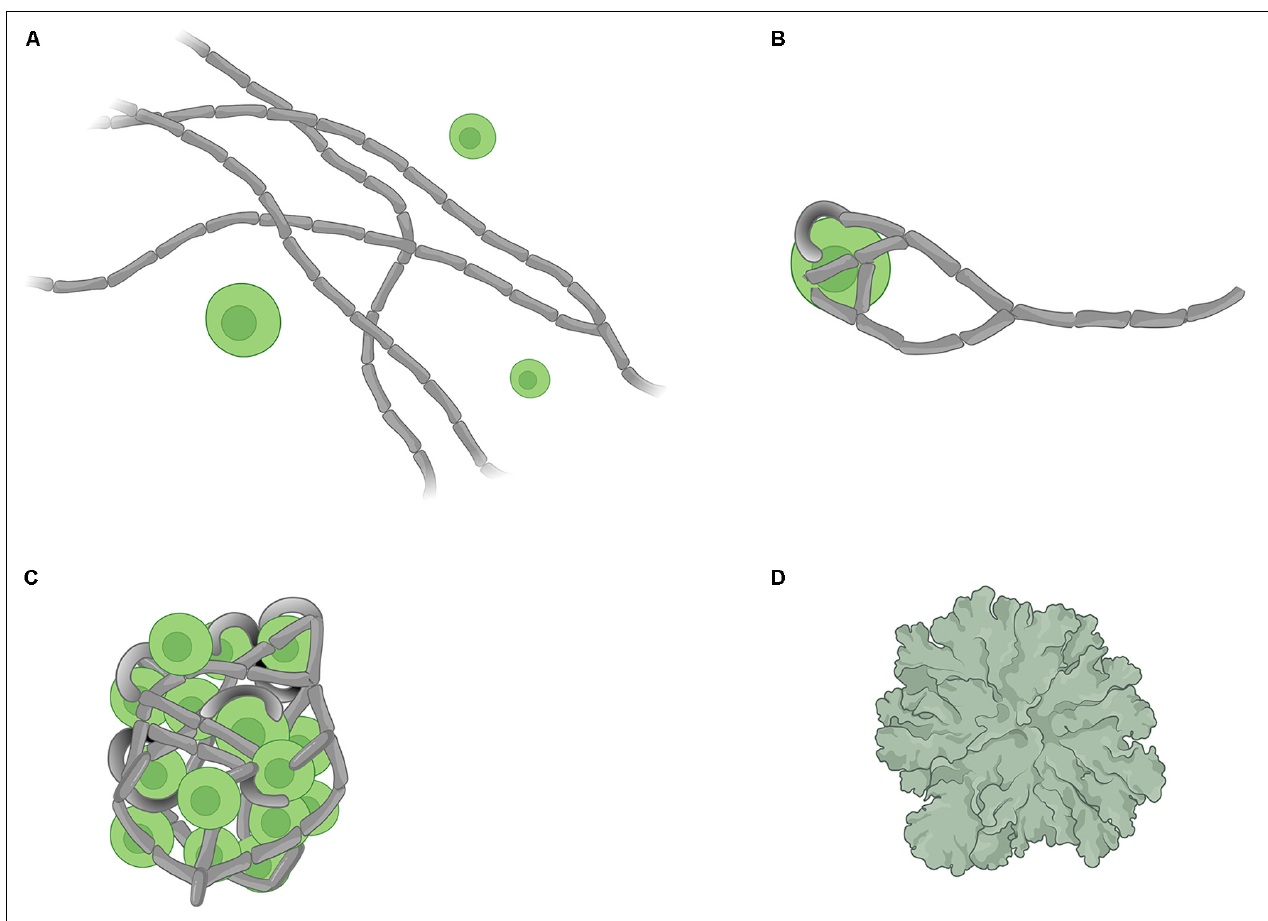
FIGURE 1 | Schematic representation of the four stages of lichen formation. (A) pre-contact where the symbionts are located at the proximity of each other but not in physical contact, (B) post-contact which marks the initiation of physical contacts between symbionts, (C) growth of an undifferentiated mass consisting of fungal hyphae and algal cells, and (D) formation of a differentiated thallus. (Image created with